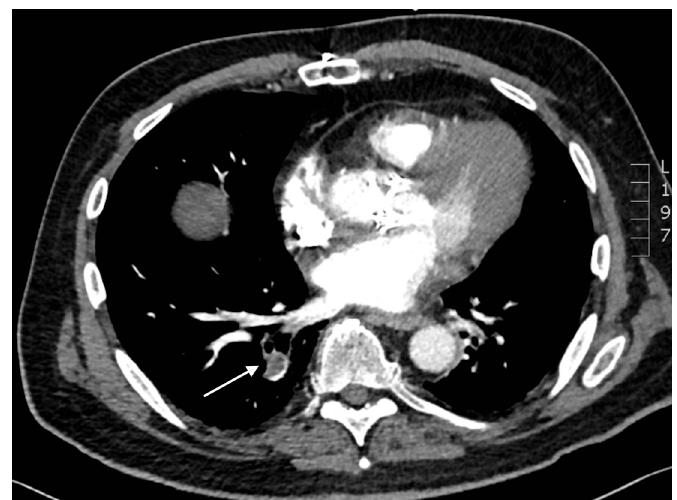
Image. Computed tomography of the chest with contrast demonstrating a right lower lobe pulmonary embolism